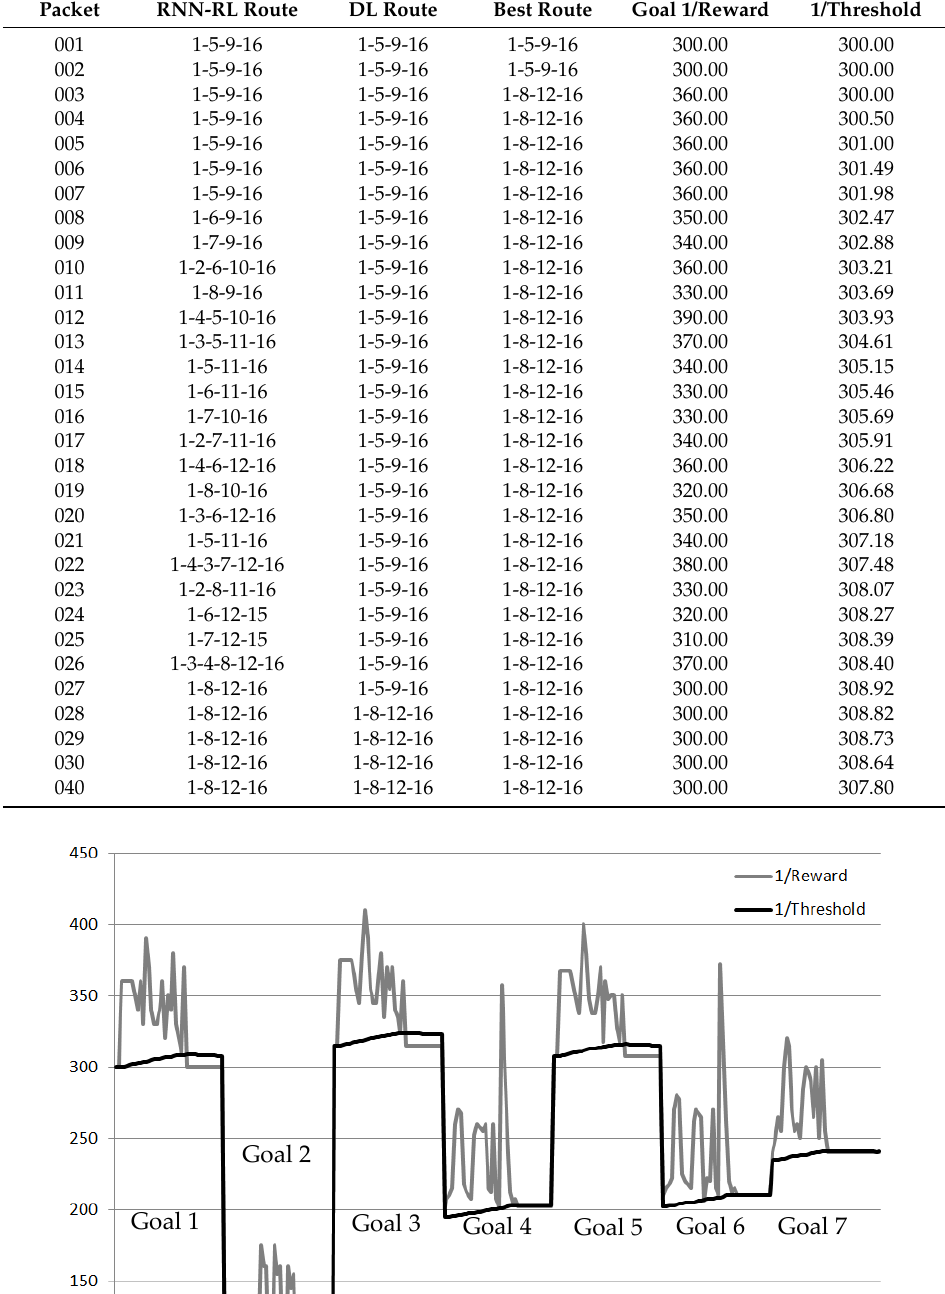
Table 13. Goal: 1 × Delay (4 × 4 Nodes).